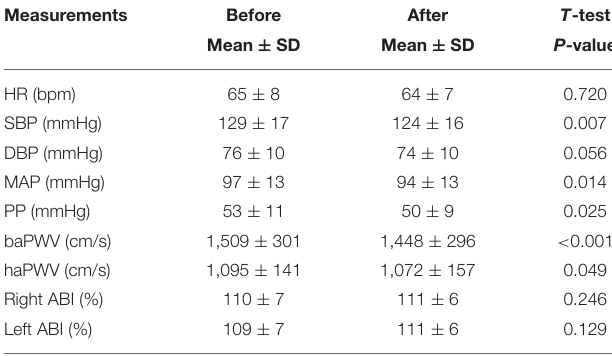
TABLE 1 | Changes in heart rate, brachial blood pressure, pulse wave velocity (PWV), and ankle-brachial index (ABI) with the aquatic exercise training